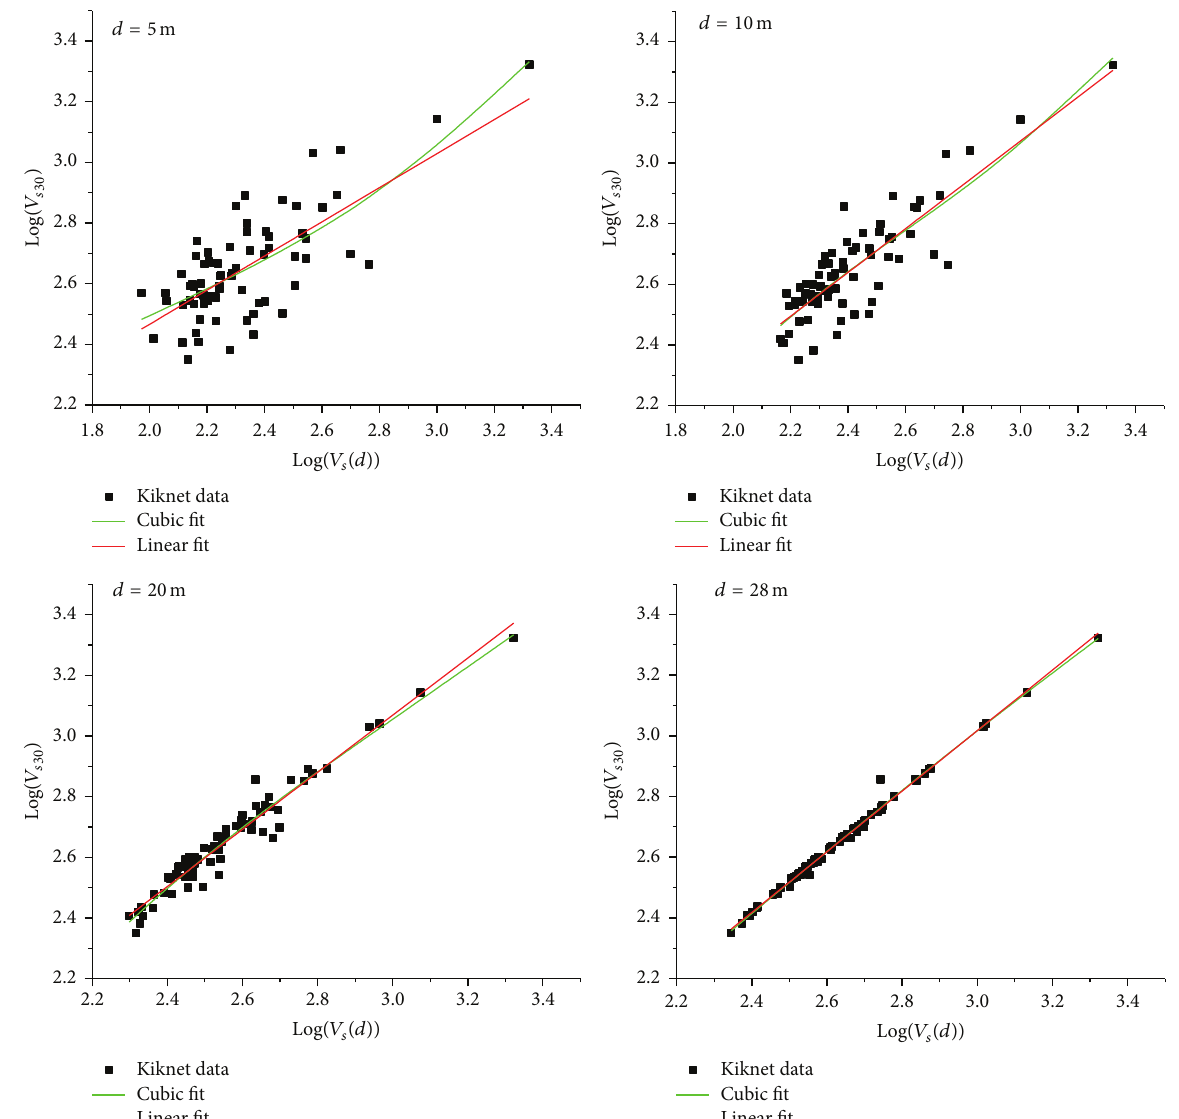
Figure 3: The linear fit and cubic fit to the Kiknet data in 4 depth bins, 5, 10, 20, and